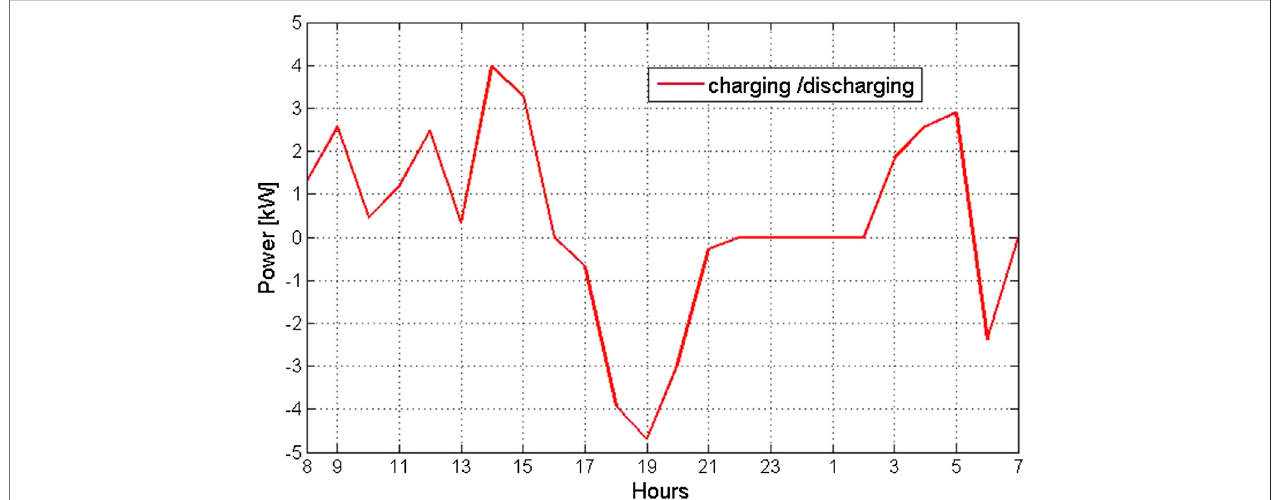
FIGURE 11 | The time-varying charging/discharging states of the energy storage system.